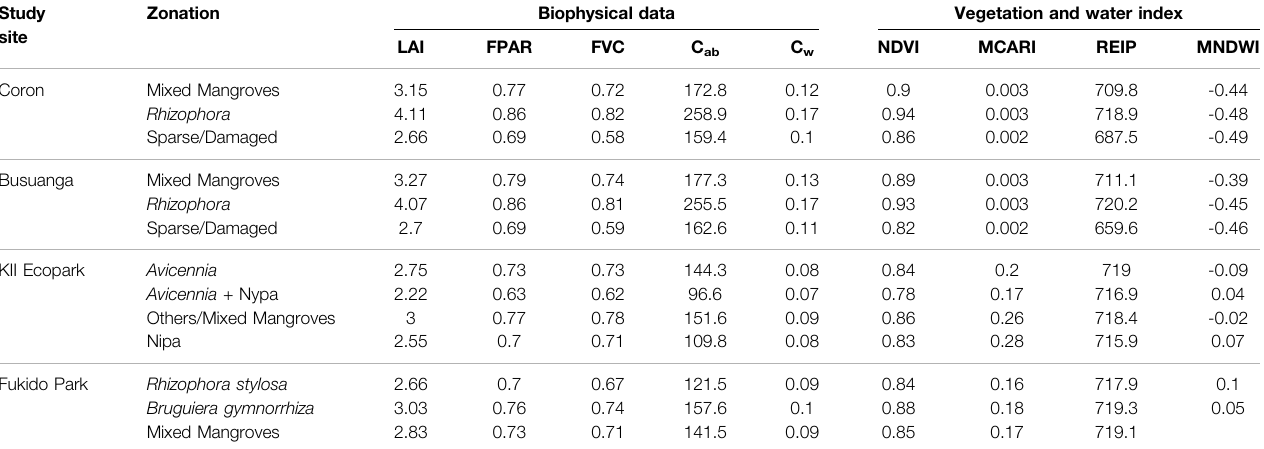
TABLE 6| MeanvaluesoftheinputSentinel-2derivedwater,vegetation,andbiophysicaldataset permangrovezonationidenti fi edinthefourstudysites: Coron, Busuanga, KII Ecopark and Fukido Park. Study